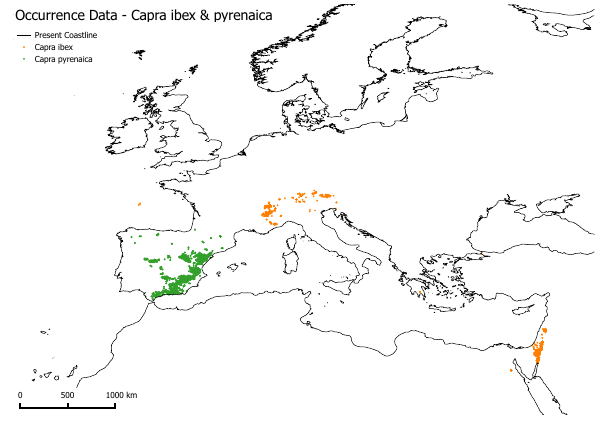
Figure 1: Occurrence Data for Capra ibex and Capra pyrenaica. (GBIF Secretariat: GBIF Backbone Taxonomy,